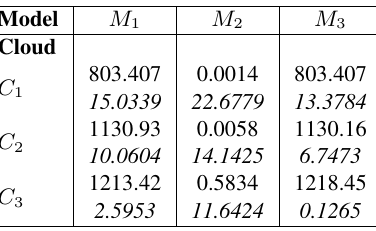
Table 1: RWMEs and DMEs between models and point clouds.